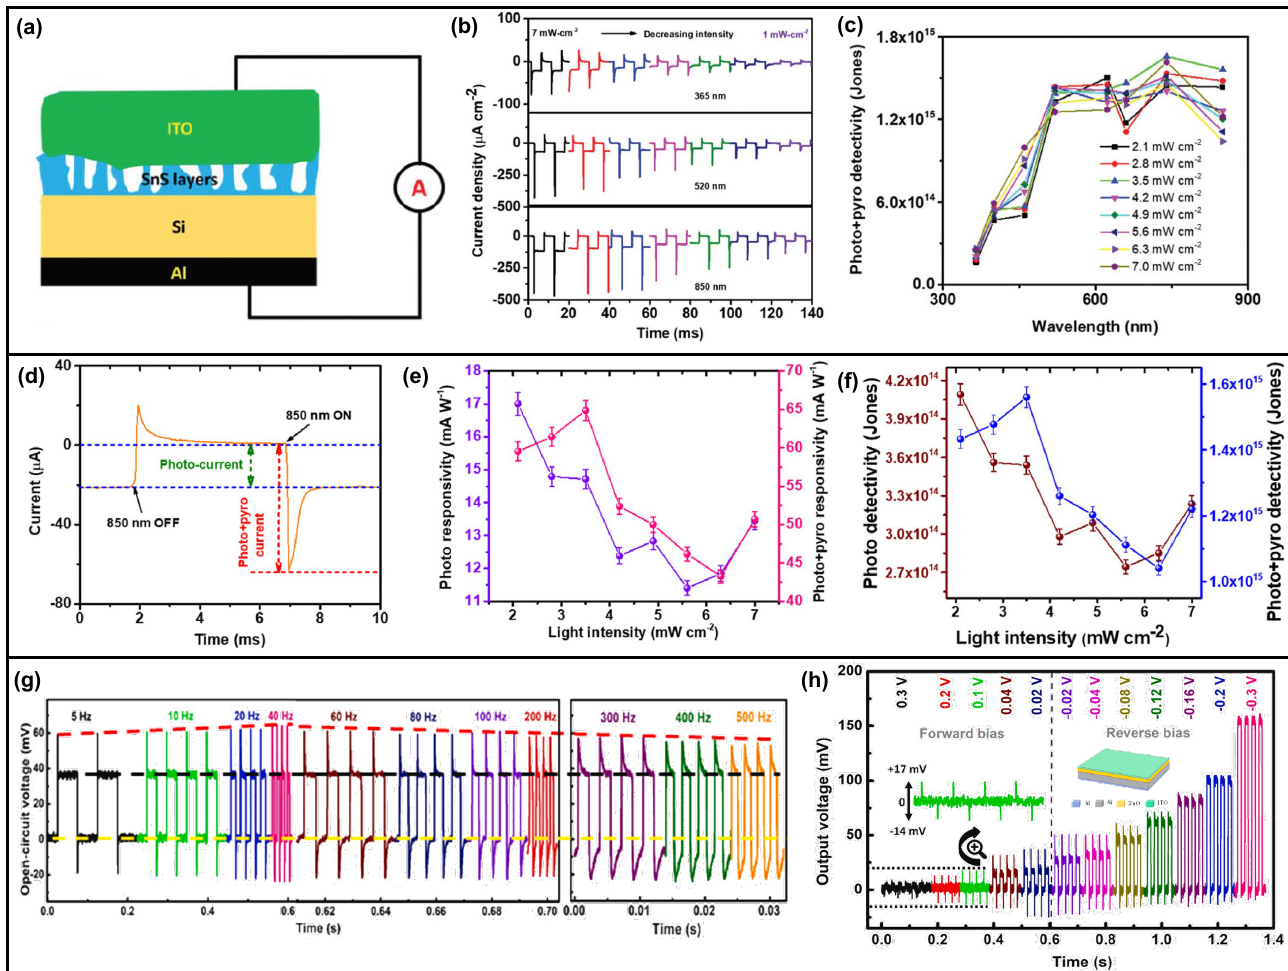
Figure 7. Pyro-phototronic-effect-enhanced photodetectors based on the self-powered ITO/SnS/Si/Al and ITO/ZnO/Si/Al device. ( a ) Cross-sectional schematic; ( b ) Pyroelectric-enhanced photoresponse properties of the SnS/Si device under different LED illumination and self-powered conditions; ( c ) D ph+py as a function of the wavelength for different intensities. Reproduced with permission from [60]. Copyright 2017 Royal Society of Chemistry; ( d ) Transient current density-time characteristics for one cycle with an intensity of 2.1 mW/cm 2 ; ( e , f ) Responsivity and detectivity for different light intensities. Reproduced with permission from [61]. Copyright 2017 Elsevier; ( g ) The transient response of the pyro-phototronic-effect-based photodetector at different frequencies of 850 nm light and at a fixed intensity of 3.40 mW/cm 2 ; ( h ) The influence of bias voltage on the photovoltaic-pyroelectric-coupling-effect-based photodetector under illumination with 3.40 mW/cm 2 of 850 nm light at 40 Hz. Inset: Schematic demonstration of architecture of p-Si/n-ZnO heterojunction photodetector. Reproduced with permission from [62]. Copyright 2022 Elsevier.